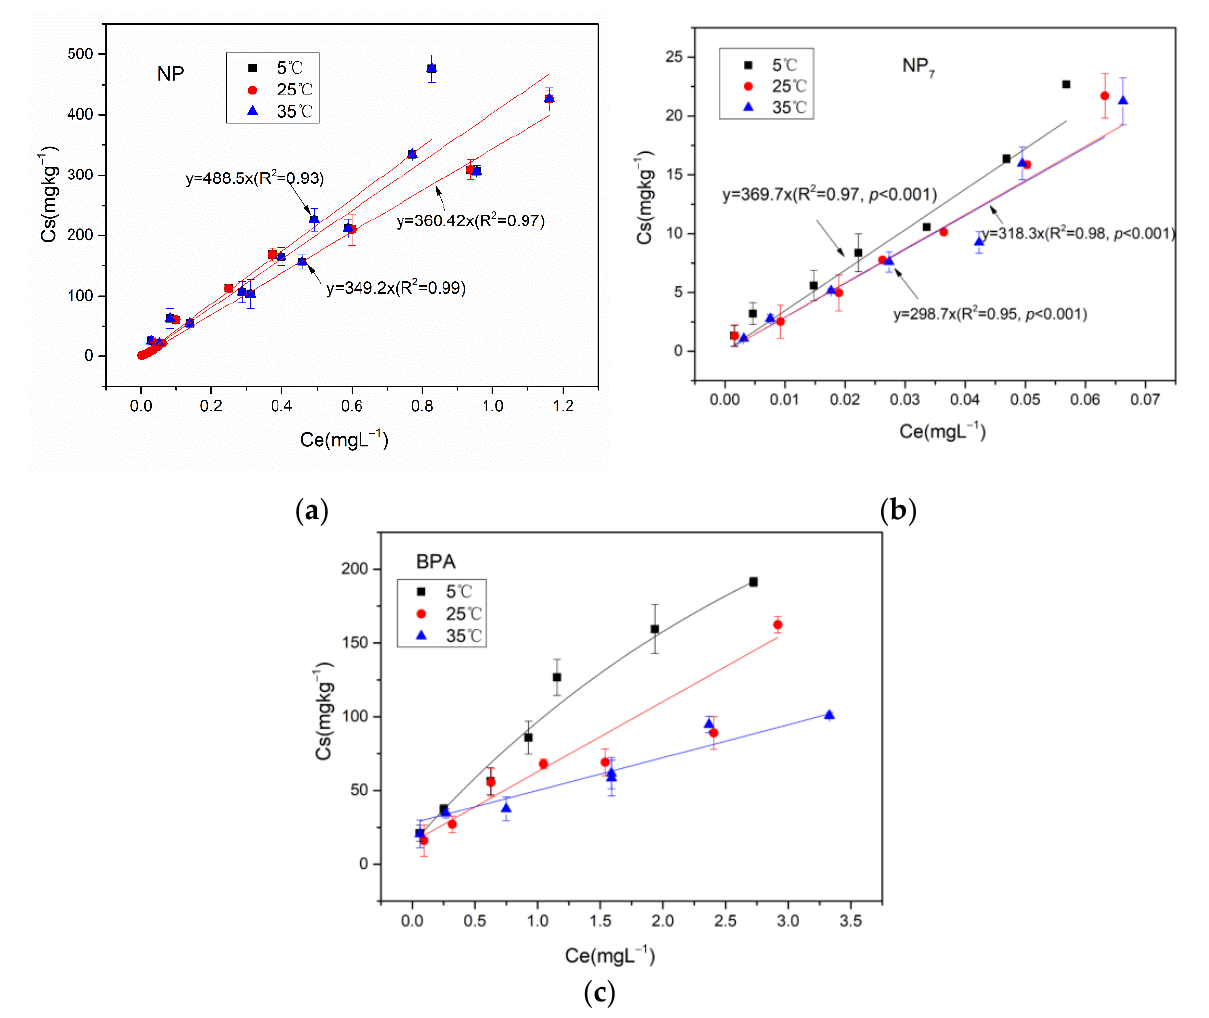
Figure 3. Adsorption of ( a ) NP, ( b ) NP 7 and ( c ) BPA on soil at different temperatures. Table 5. Freundlich model for BPA on soil at different temperatures. Temperature ( ◦